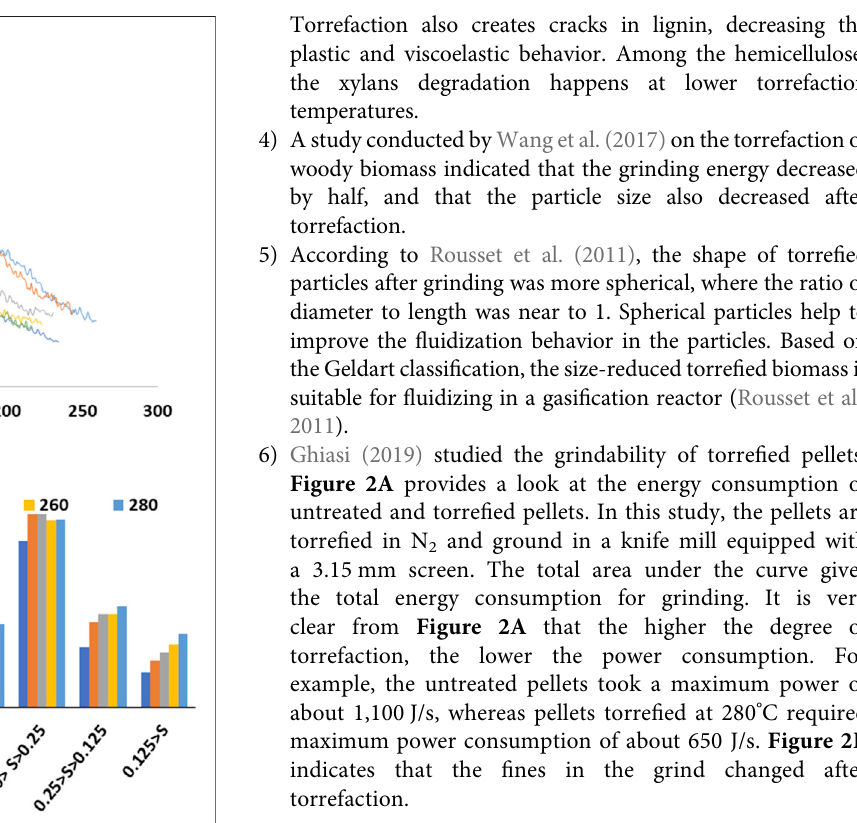
Frontiers in Energy Research |